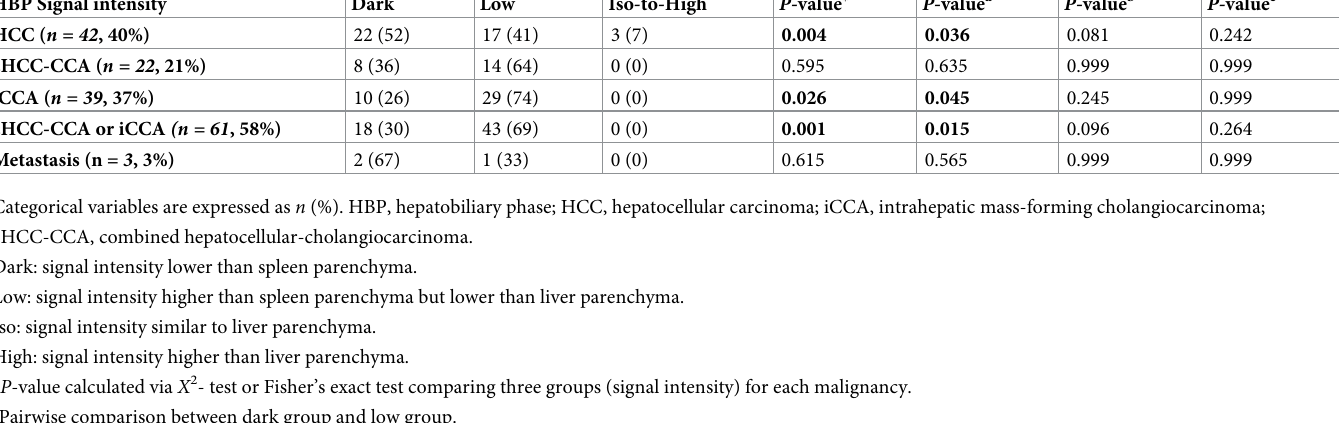
Table 3. Hepatobiliary phase (HBP) signal intensities of HCC and non-HCC malignancies. HBP Signal